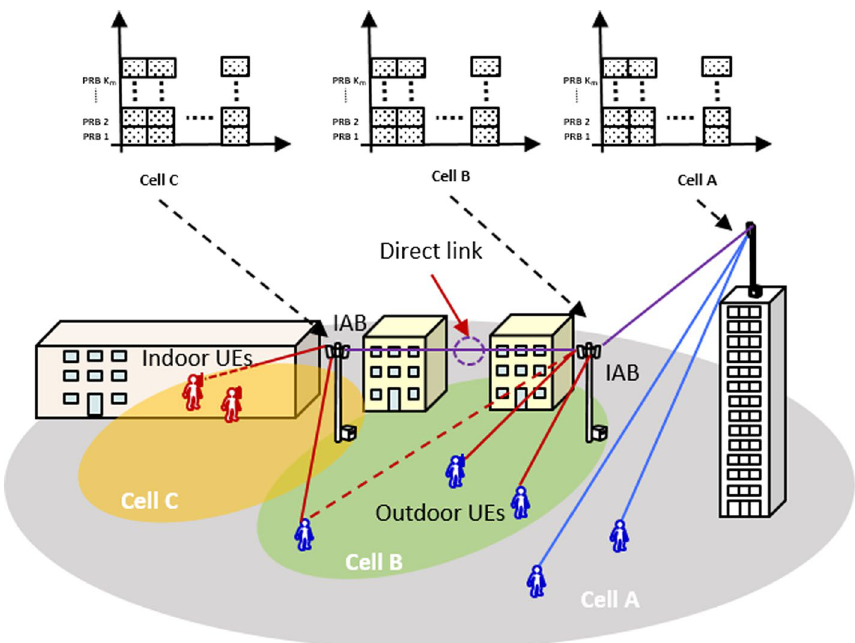
Fig. 8 A network with | C | = 1 macro-cell and | R | = 2